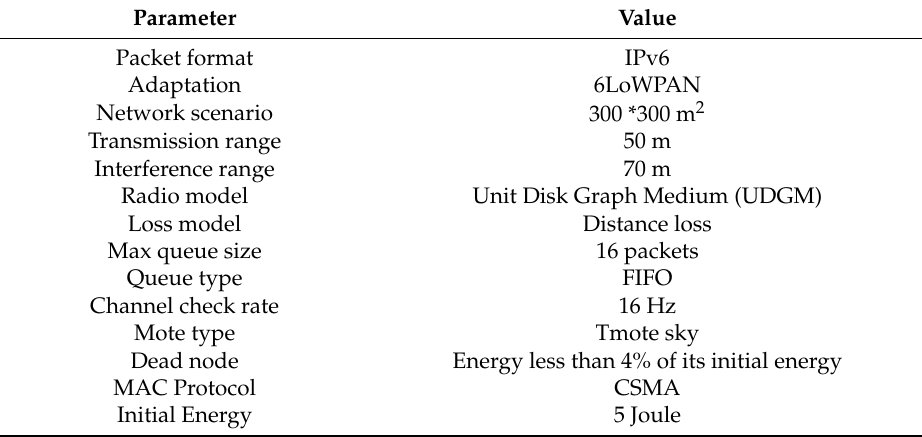
Table 3. Simulation experiment